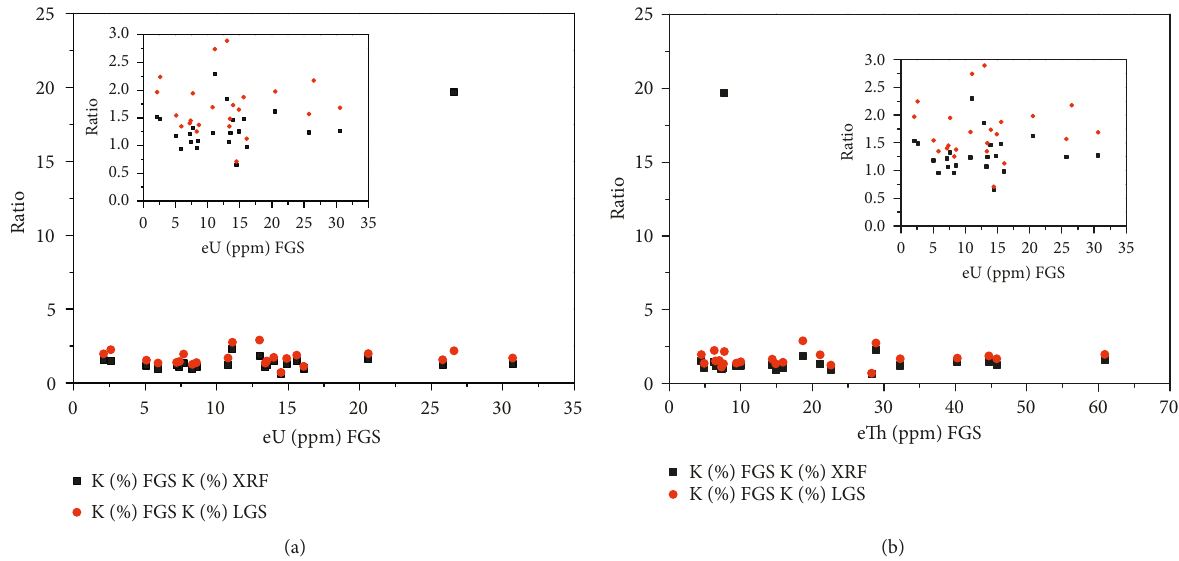
Figure 6: Plots for the comparison of estimates of eU (a) and eTh (b) versus K (%) ratios obtained by FGS, XRF, and LGS. The K ratios correspond to K (FGS)/K (XRF) and K (FGS)/K (LGS). The insets show a detail of the whole plots in the range 0–3 of the ratio and 0 to 35ppm for eU and eTh. No correlation is observed between the